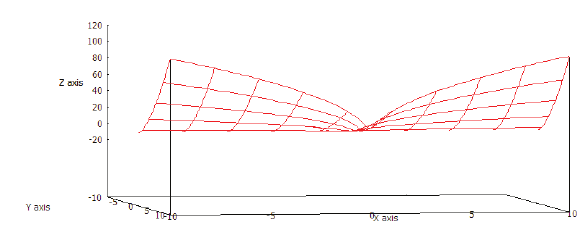
Fig. 7. Dynamics of transformation function, (cid:86) ( x , y ) .